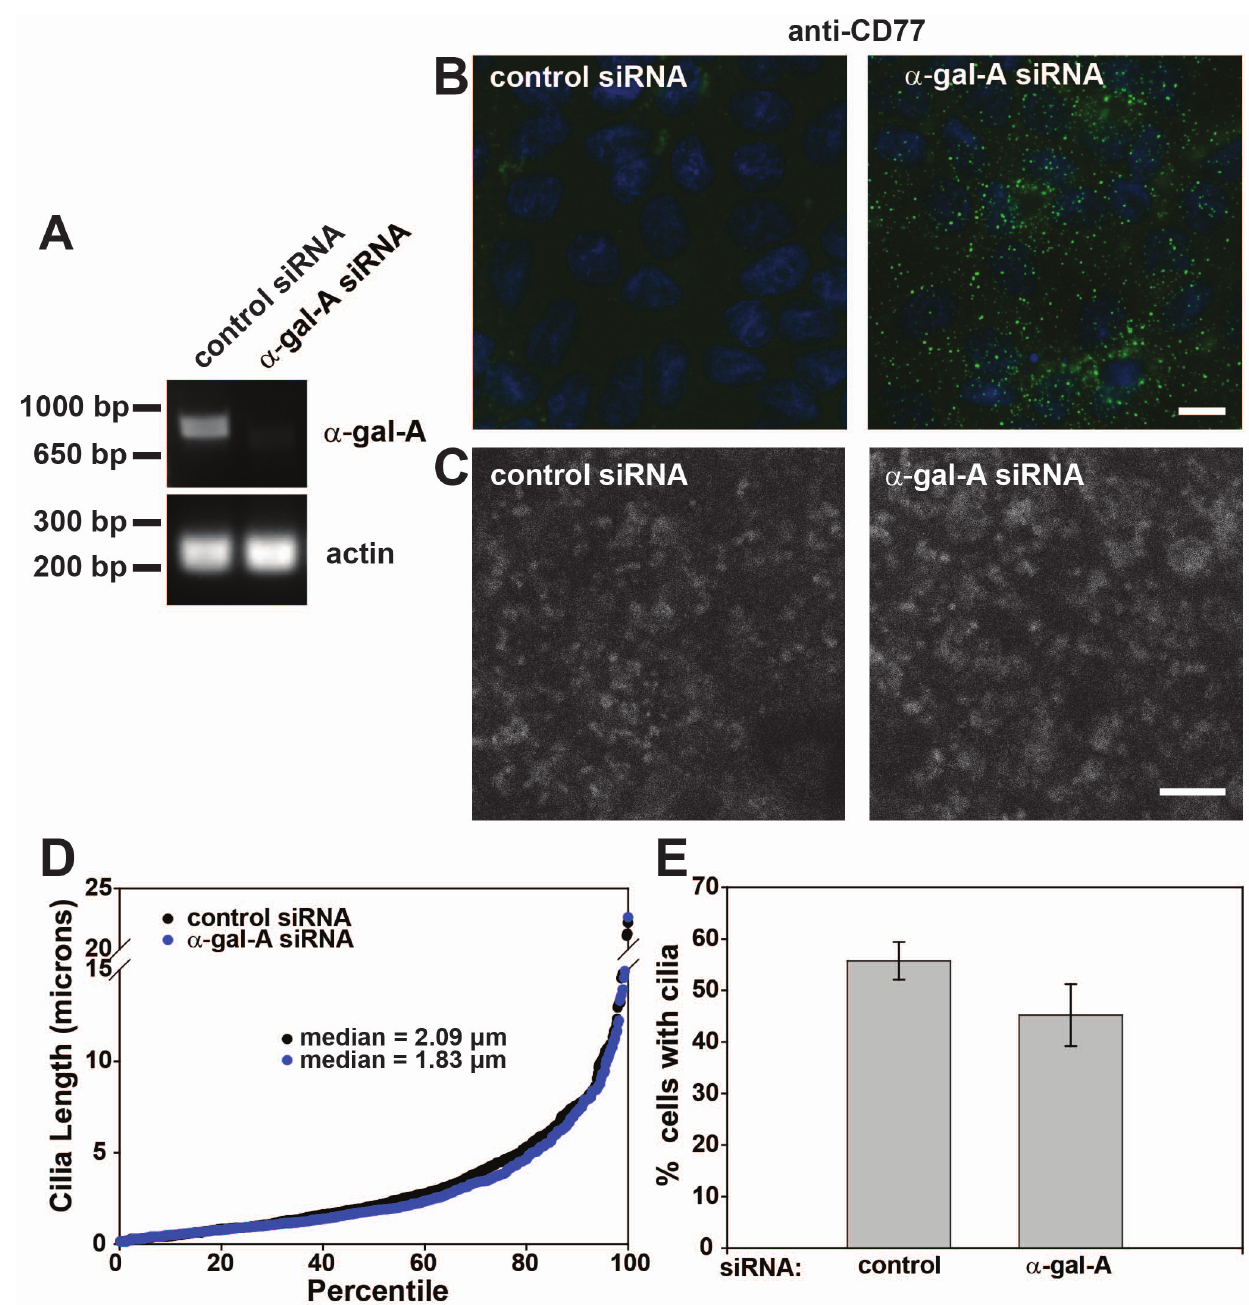
Figure 6. Perturbing lysosomes has no effect on ciliogenesis. MDCK cells were transfected with control or a -gal-A siRNA and cultured for four days on permeable supports, then harvested for (A) RT-PCR (expected products are 898 bp for a -gal-A and 231 bp for actin) or (B–E) processed for immunofluorescence. (B) Knockdown of a -gal-A caused a dramatic cellular accumulation of its substrate Gb3, as shown by indirect immunofluorescence using the anti-Gb3 antibody CD77. Scale bar=10 m m. (C) Knockdown of a -gal-A lead to an increase in late-endosome/ lysosome size, and a decrease in the number of these structures, shown by indirect immunofluorescence of LAMP2. Scale bar=5 m m. (D) Cilia were detected using anti-acetylated tubulin antibody, and cilia from random fields were measured and counted using ImageJ. The cilia were sorted by length in ascending order and graphed by percentile as in Fig. 4. (E) The number of cilia in each field was divided by the number of nuclei (identified using DAPI staining) and the mean + / 2 SEM of three experiments is shown. There is not a significant difference in cilia length or in the percent of cells with cilia in control and a -gal-A siRNA transfected cells as assessed by t-test of the medians in three experiments. Data represent measurements from 1,535 cells for control siRNA and 1,407 cells for a -gal-A siRNA-treated cells. Scale bar=10 m m. doi:10.1371/journal.pone.0086425.g006 frequency (Figure 6E) was significantly altered in a -gal A-depleted cells compared with controls, suggesting that there is no direct link Many proteins that have been implicated in ciliogenesis also between disrupted lysosome function and ciliogenesis. have a functional effect on cyst formation [43,44,53–57]. Thus, we